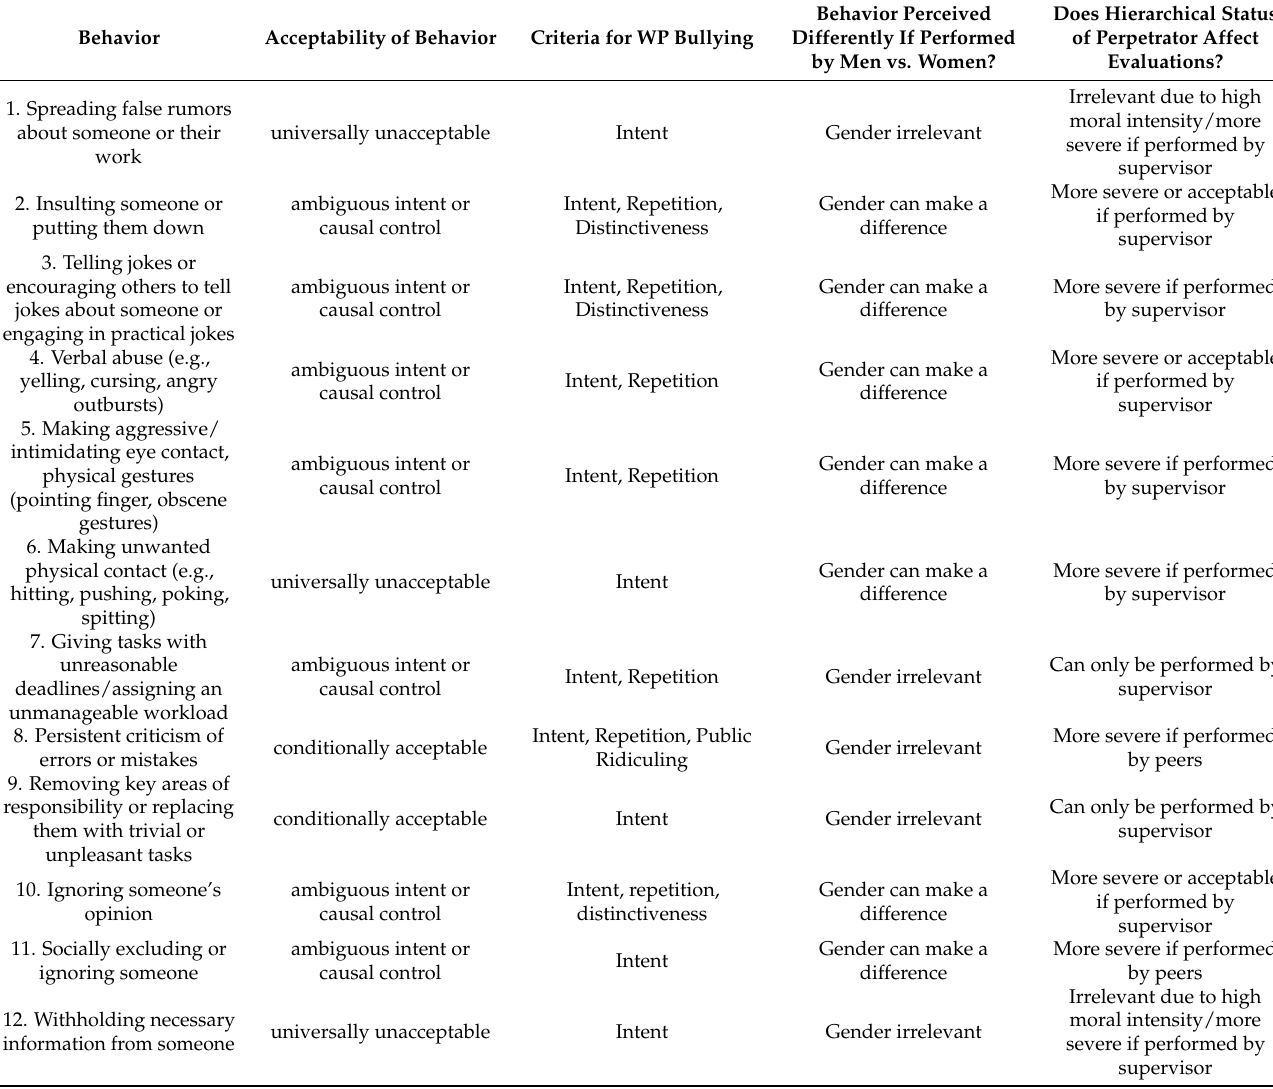
Table A1. Overview on third-party responses and the impact of gender and hierarchical status on moral